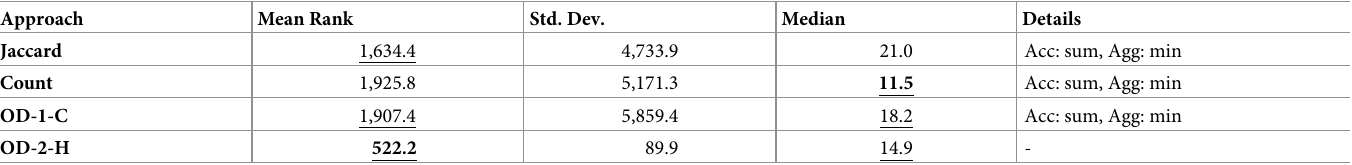
Table 5. Open discovery: Mean and median ranks on all open discovery Cases. Approach Mean